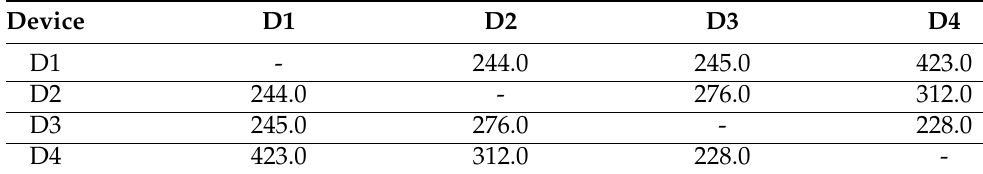
Table 2. Distance measurement results using